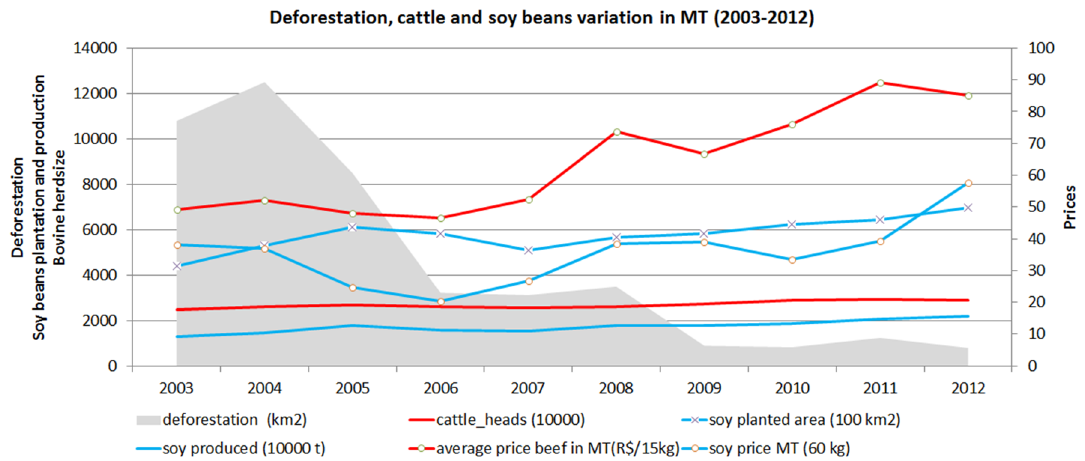
Figure 1. Deforestation, cattle and soy beans variation in Mato Grosso (2003–2012). Source: author, based on [11–14].